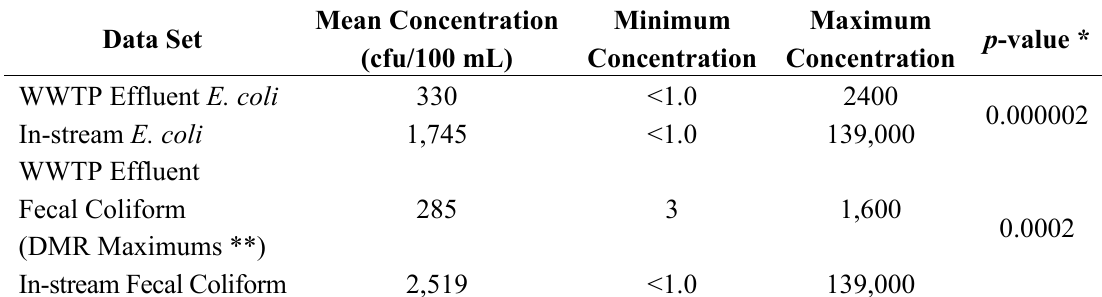
Table 6. Statistical summary of in-stream and WWTP effluent fecal coliform and E. coli concentrations. All units are cfu/100